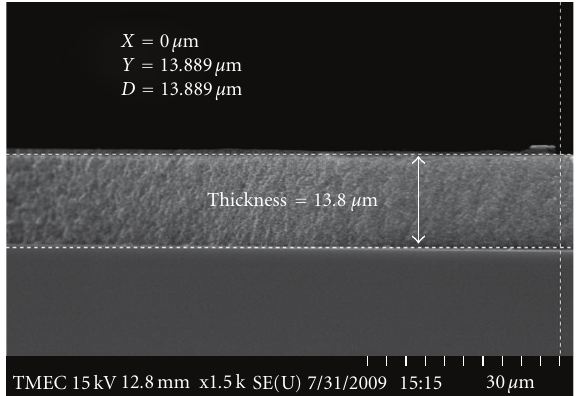
Figure 1: An SEM image showing a cross-section of the TiO 2 film.